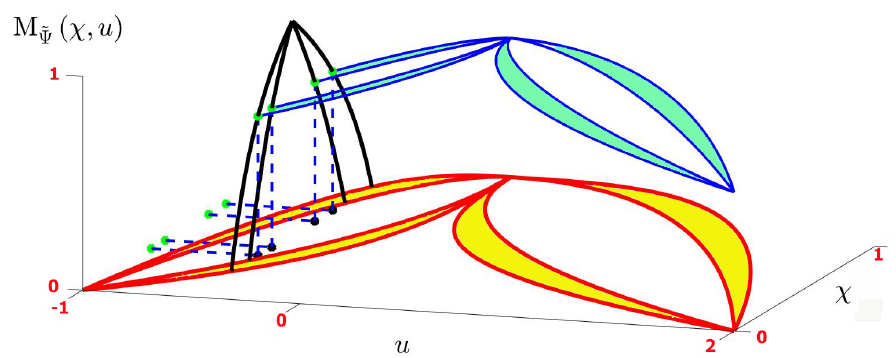
Figure 3. Type-3